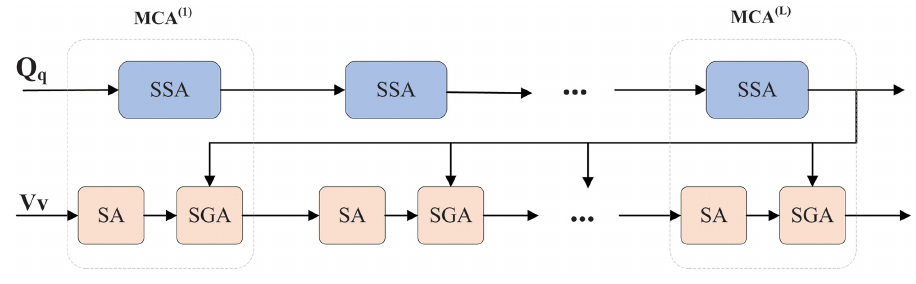
Fig 5. Co-attention structure